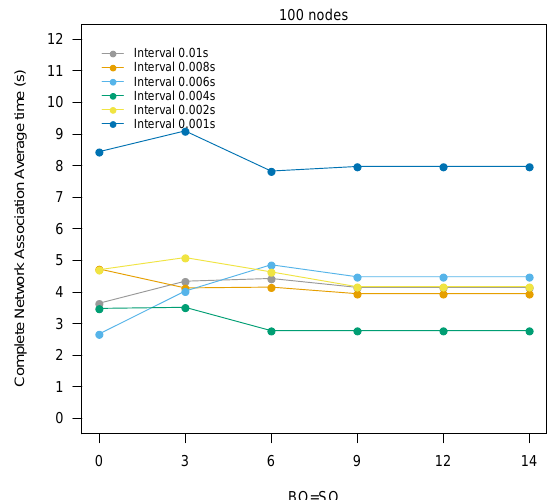
Figure 13. Full network association time with different beacon intervals.